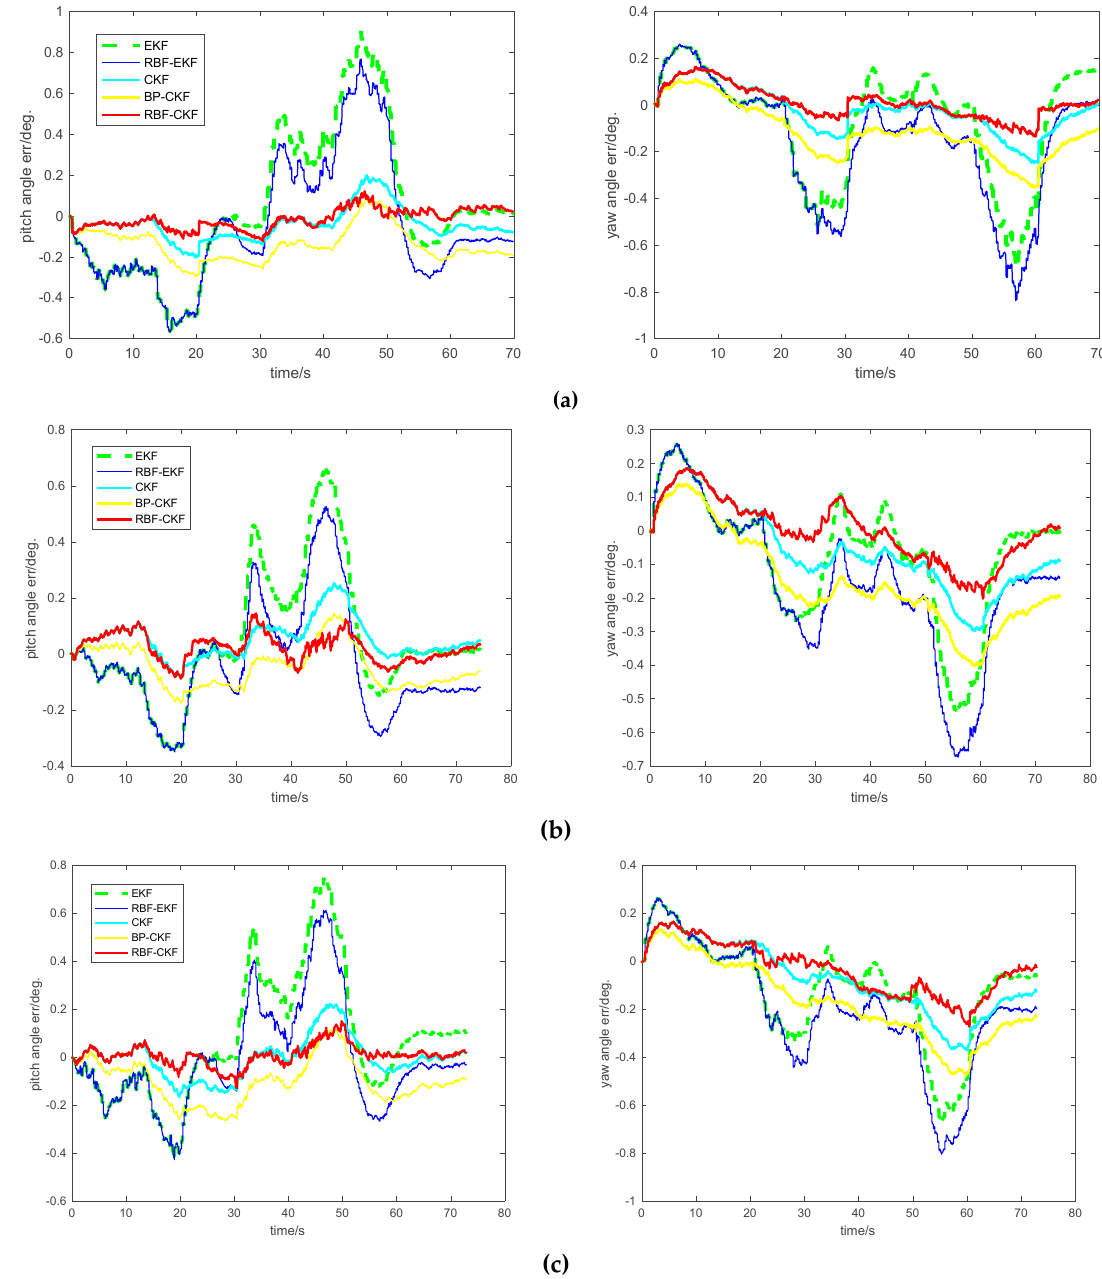
Figure 9. ( a ) The attitude errors of experiment one; ( b ) The attitude errors of experiment two; ( c ) The attitude errors of experiment Figure 9(c). The attitude errors of experiment three.